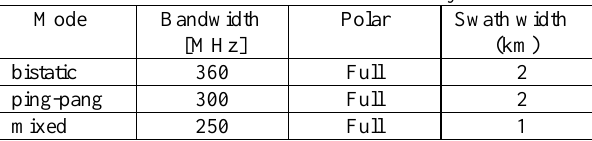
Table 1.Parameters of Multi-mode-XSAR